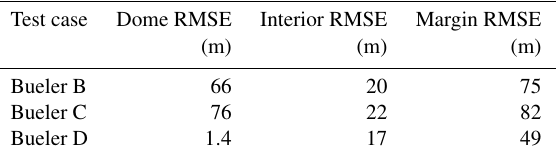
Table 3. Results of prediction at t 0 + 100 years. RMSE stands for root mean squared error. This is calculated by taking the average of the squared difference between the actual glacial thickness values and predicted glacial thickness values, and then taking the square root.